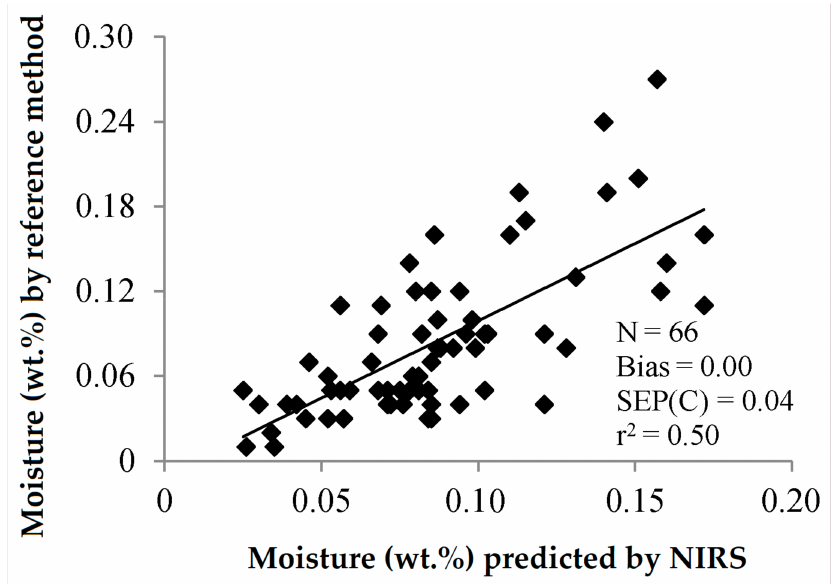
Figure 13. Validation exercise for the determination of the moisture and volatile matter content of olive oil by PLS-NIRS using all the wavelengths between 400 and 2500 nm